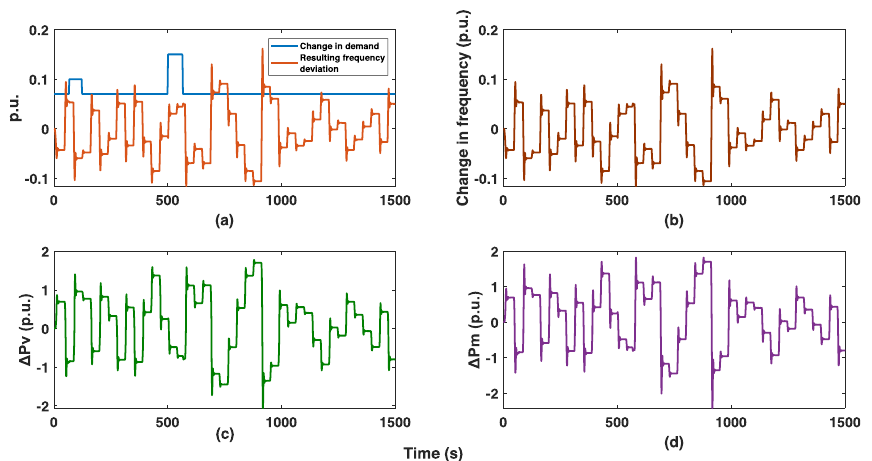
Fig. 11 System response during changes in demand and frequency measurement noise variance of 0.1: a Variation in Δ f; b Frequency response during control action; c Variation of states Δ P v ; d Variation of states Δ P m